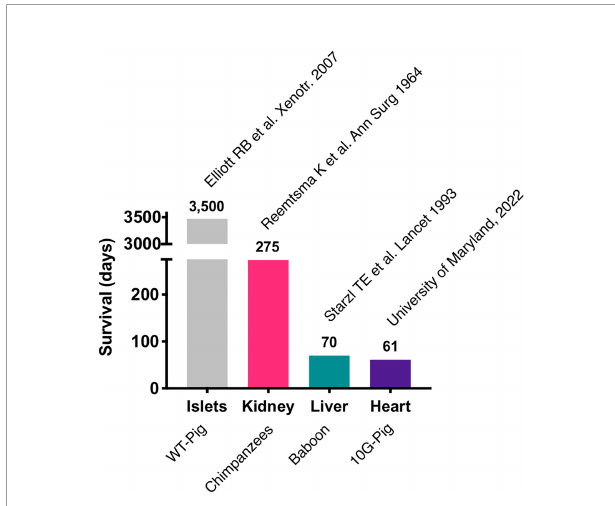
FIGURE 1 | Longest survival of xenotransplanted organs or tissues in human. WT, wild